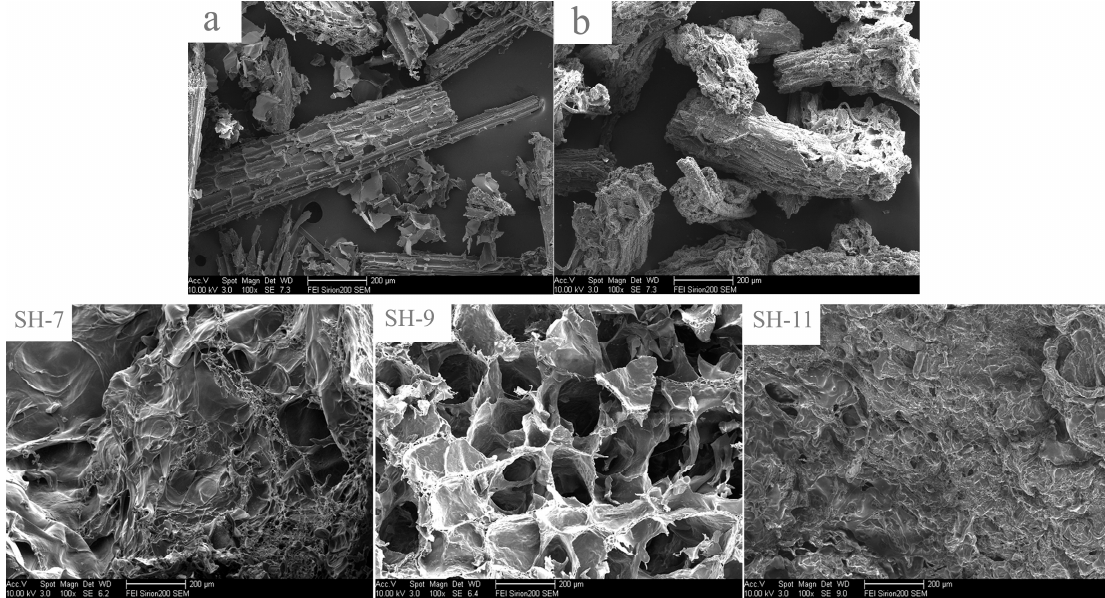
Figure 6. SEM micrographs of straw ( a ), pretreated straw ( b ), and hydrogels (SH-7, SH-9,